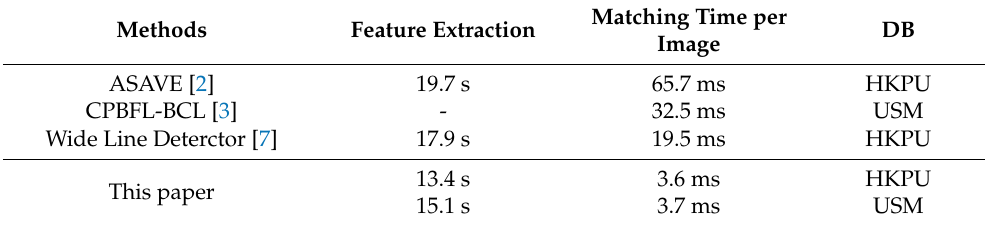
Figure 6. Performance comparison of LBP, MB-LBP, CS-LBP, and BACS-LBP. Table 5. Time comparison.